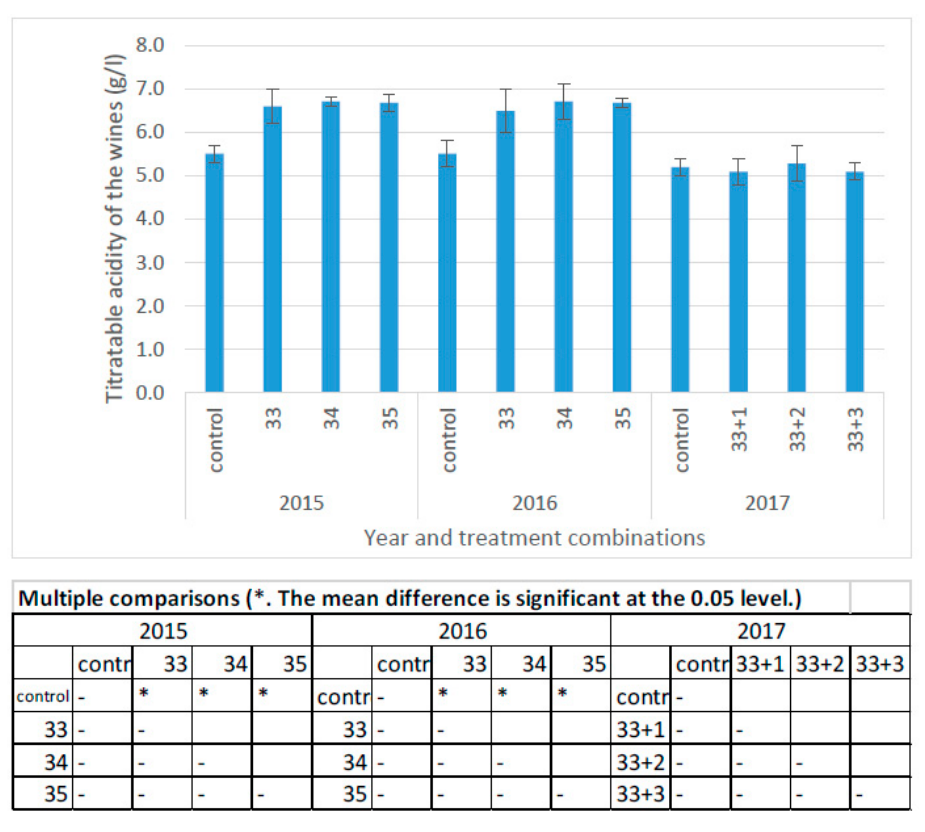
Figure 6. Titratable acidity of the wines in 2015–2017 (g/L).